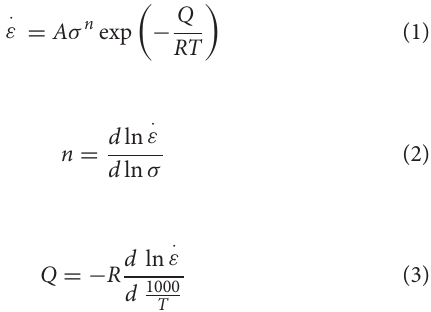
strength of TMCs is higher than that of matrix alloy. Significantly, which increased by about 12, 26, and 50% treated by HT1 at 873, 923, and 973 K. The ultimate strength and elongation of TMCs improve significantly at high temperature, compared with those of matrix alloy. The tensile properties of HT2 are superior to that of HT1 at high